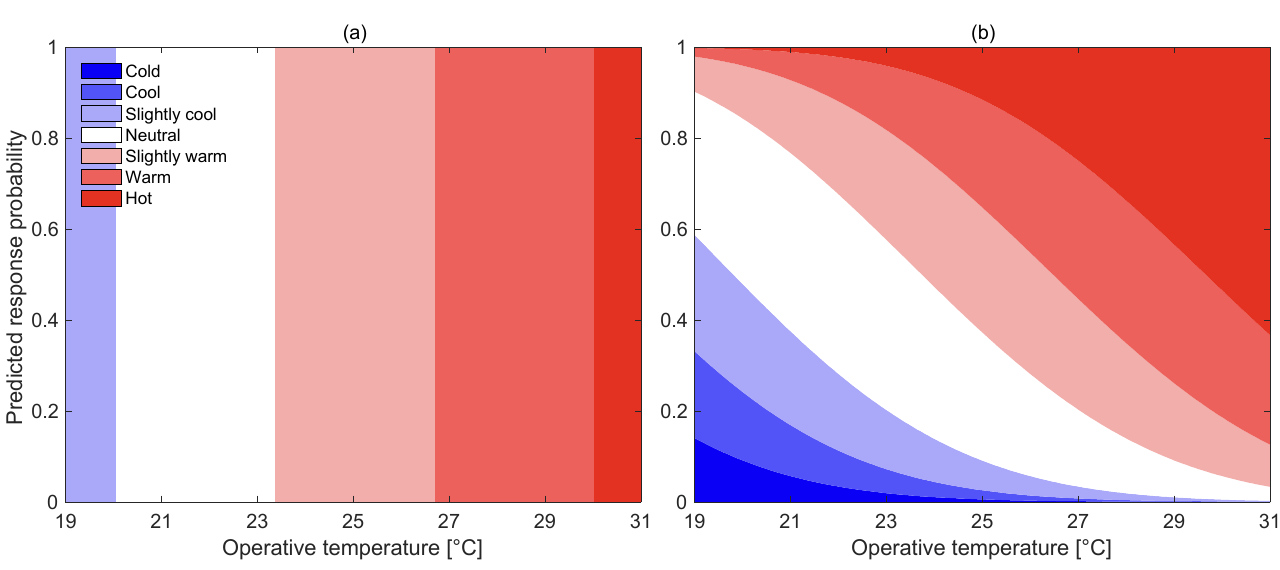
Figure 3. Observational percentage of occupants responding to each TSV category from the ( a )